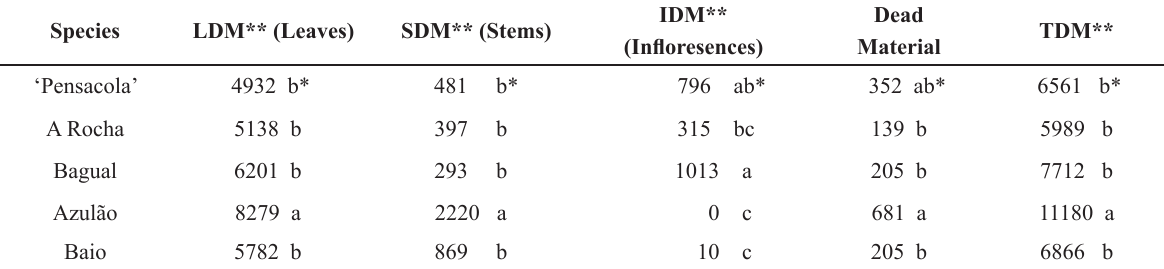
Dry matter production of the components of the aerial part, and the total in kg/ha, of the Paspalum spp. and cv. ‘Pensacola’ ecotypes in the second year of evaluation, Eldorado do